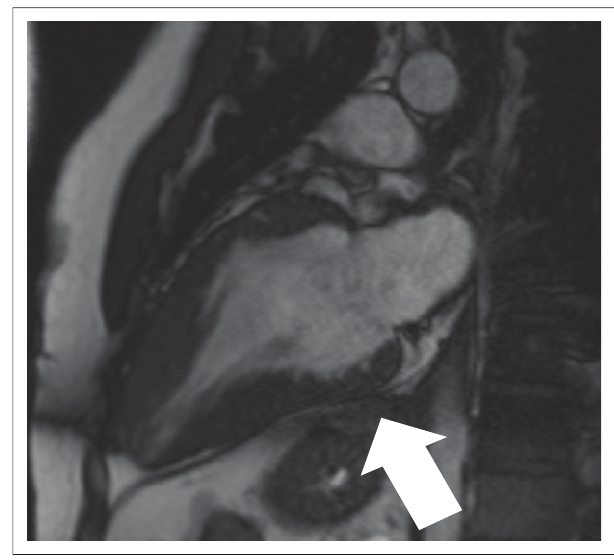
FIGURE 4: An apical micro-aneurysm. These are hard to see by echocardiography in many cases.